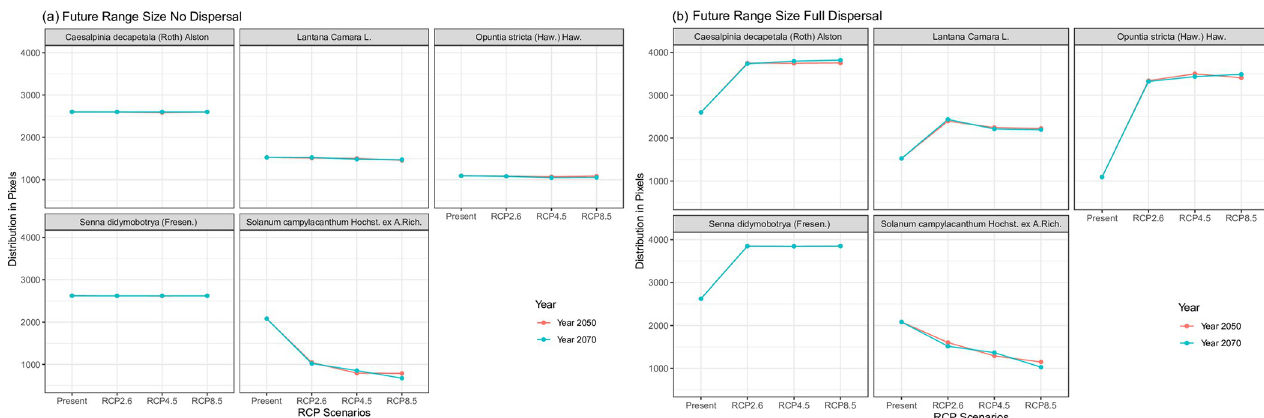
Fig 5. Predicted suitable areas under changing climate scenarios assuming no dispersal and full / unlimited dispersal of the species.